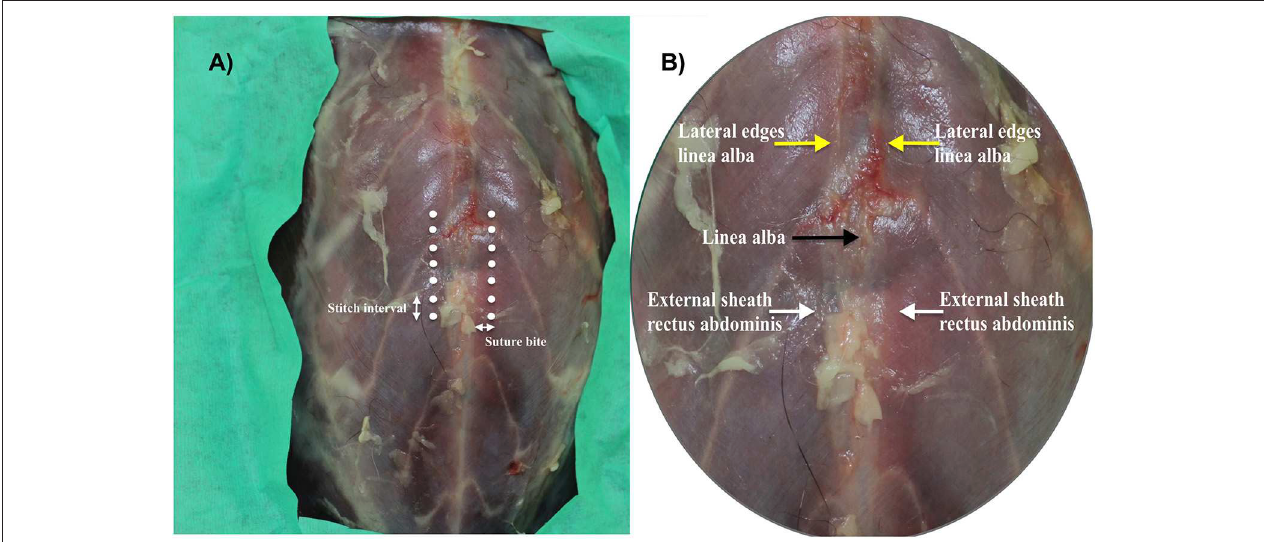
FIGURE 2 | (A) Specimen showing suture-bite and stitch intervals (SBSI). (B) Close view of the same specimen showing the linea alba (black arrow), the lateral edges of the linea alba (yellow arrows) and the external leaf of the rectus abdominis (white arrows). At the microscopic level, the area between the lateral edges of the linea alba and the external sheath of the rectus abdominis is the transition zone ( 16).